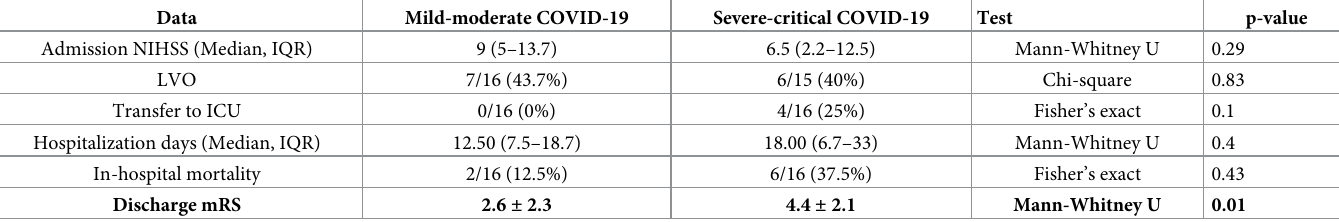
Table 2. Comparing clinical characteristics of mild-moderate vs. severe-critical COVID-19 AIS patients.